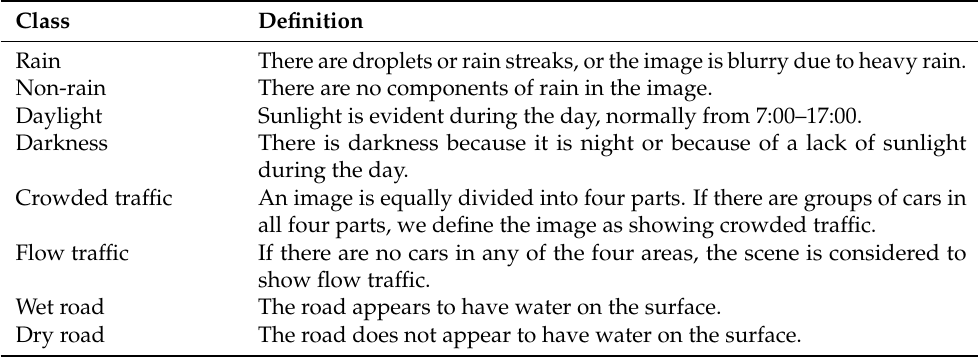
Table 1. Class definition of the dataset.